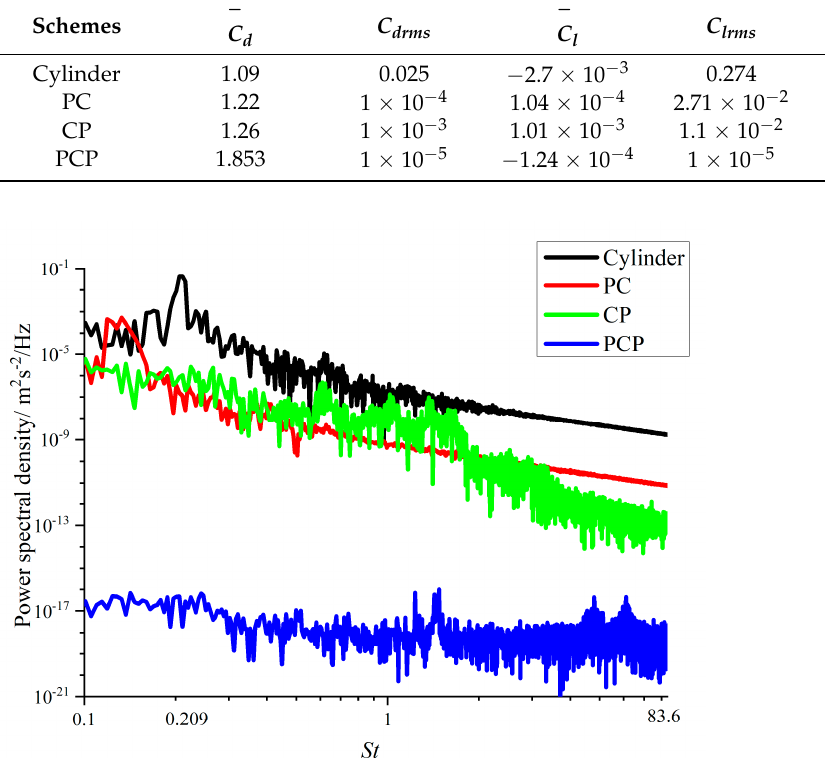
Figure 13. Power spectral density of unsteady lift coefficient.